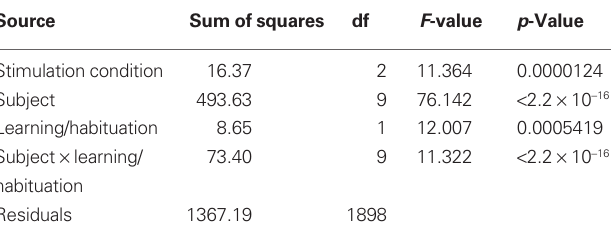
Table 1 | Analysis of covariance for the cathodal group.